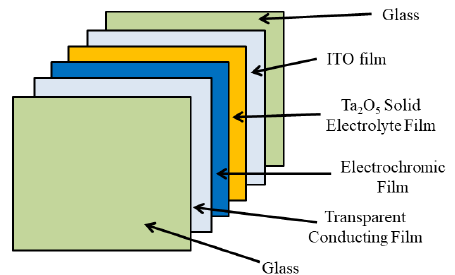
Figure 4. Structure of an all-solid-state ECD based on Ta 2 O 5 solid electrolyte film.